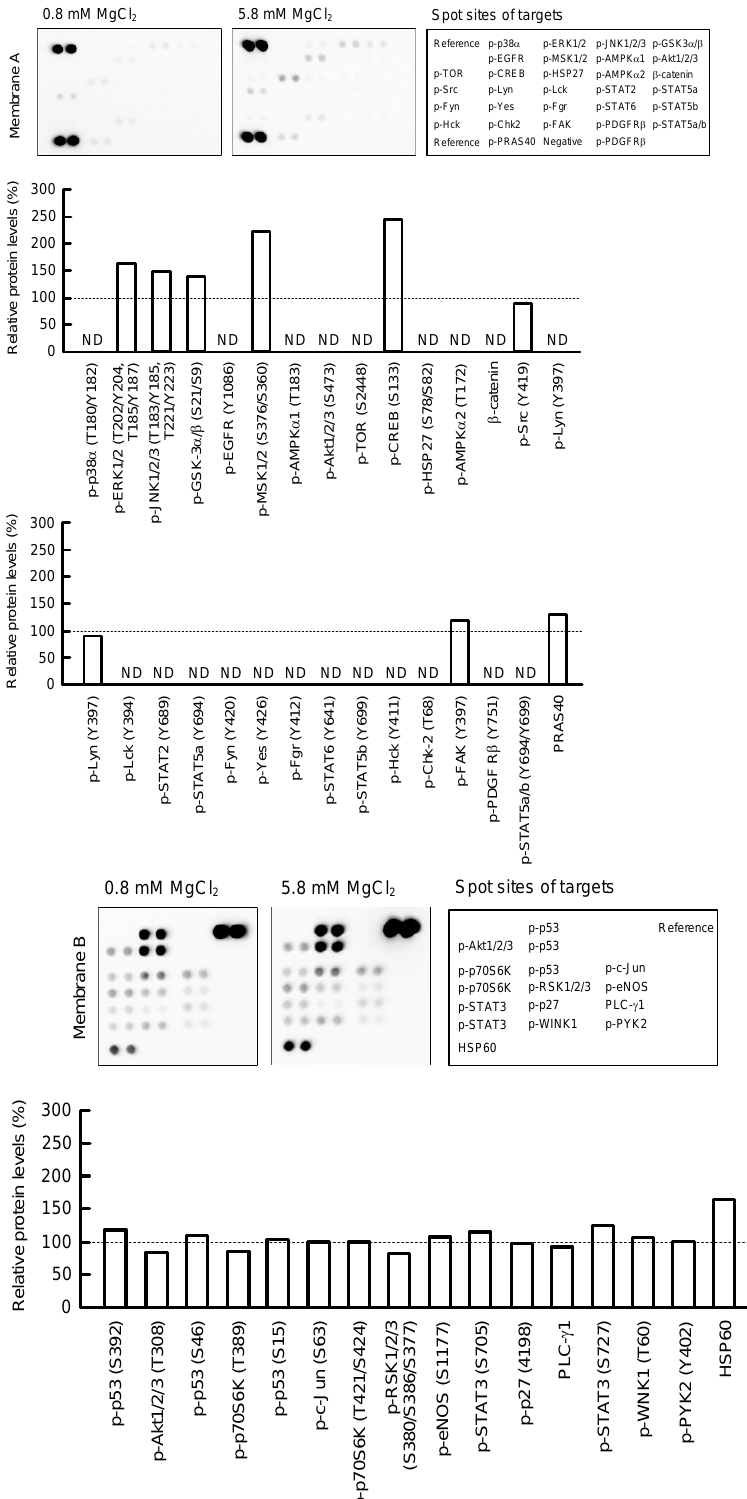
Figure 6. Effect of MgCl 2 supplementation on phosphorylation of intracellular signaling proteins. Cells were incubated in 0.8 and 5.8 mM MgCl 2 media for 6 h. After collecting whole cell lysates, the aliquots were applied on a Proteome Profiler Human Phospho-Kinase Array Kit. Upper images indicate the membrane A and B, and spot sites of targets. Lower images indicate the phosphorylation level or total amount are represented as a percentage of 0.8 mM MgCl 2 . A signal below the detection limit is indicated by non-detectable (ND).